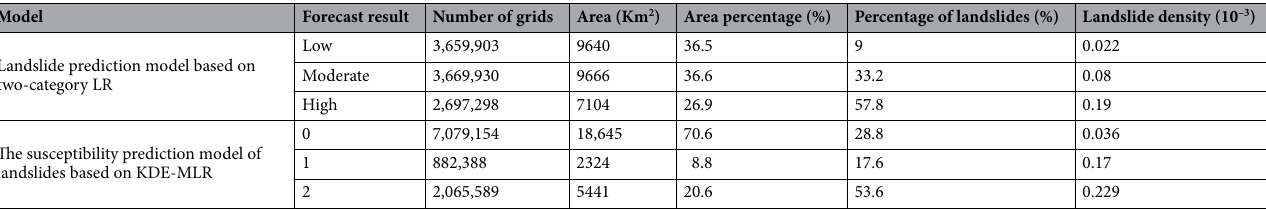
Table 6. Forecast result statistics chart.